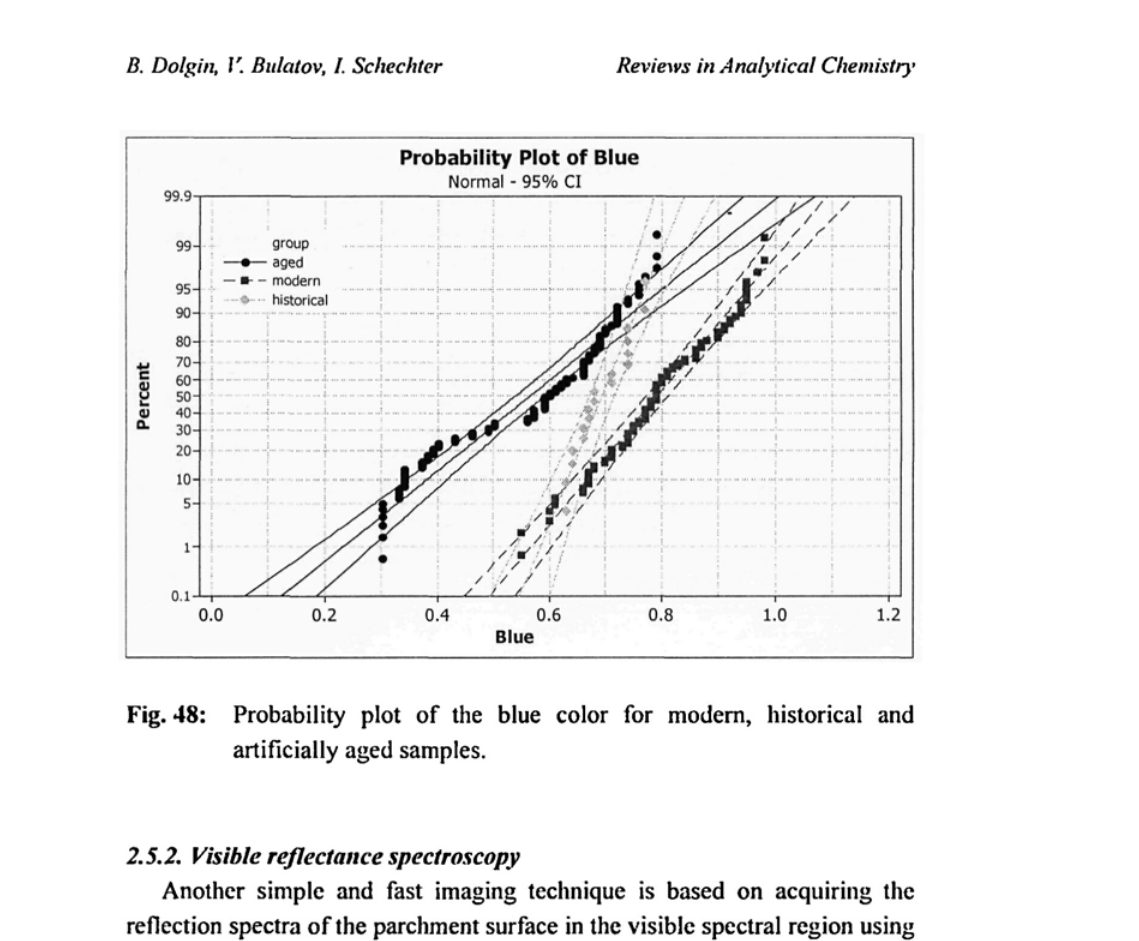
Fig. 48: Probability plot of the blue color for modern, historical and artificially aged